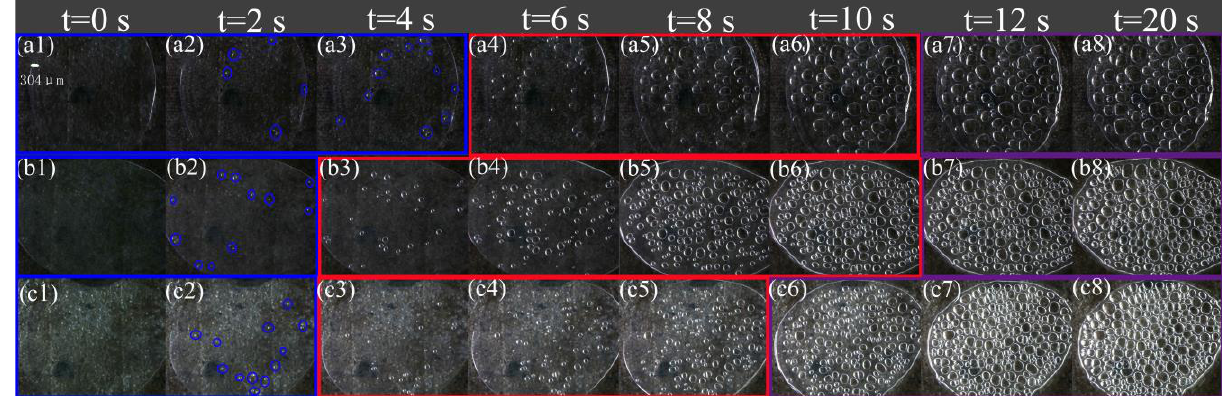
Figure 6. Video screenshots at different times: ( a ) 0.5 wt.%, ( b ) 0.6 wt.%, ( c ) 0.7 wt.%.